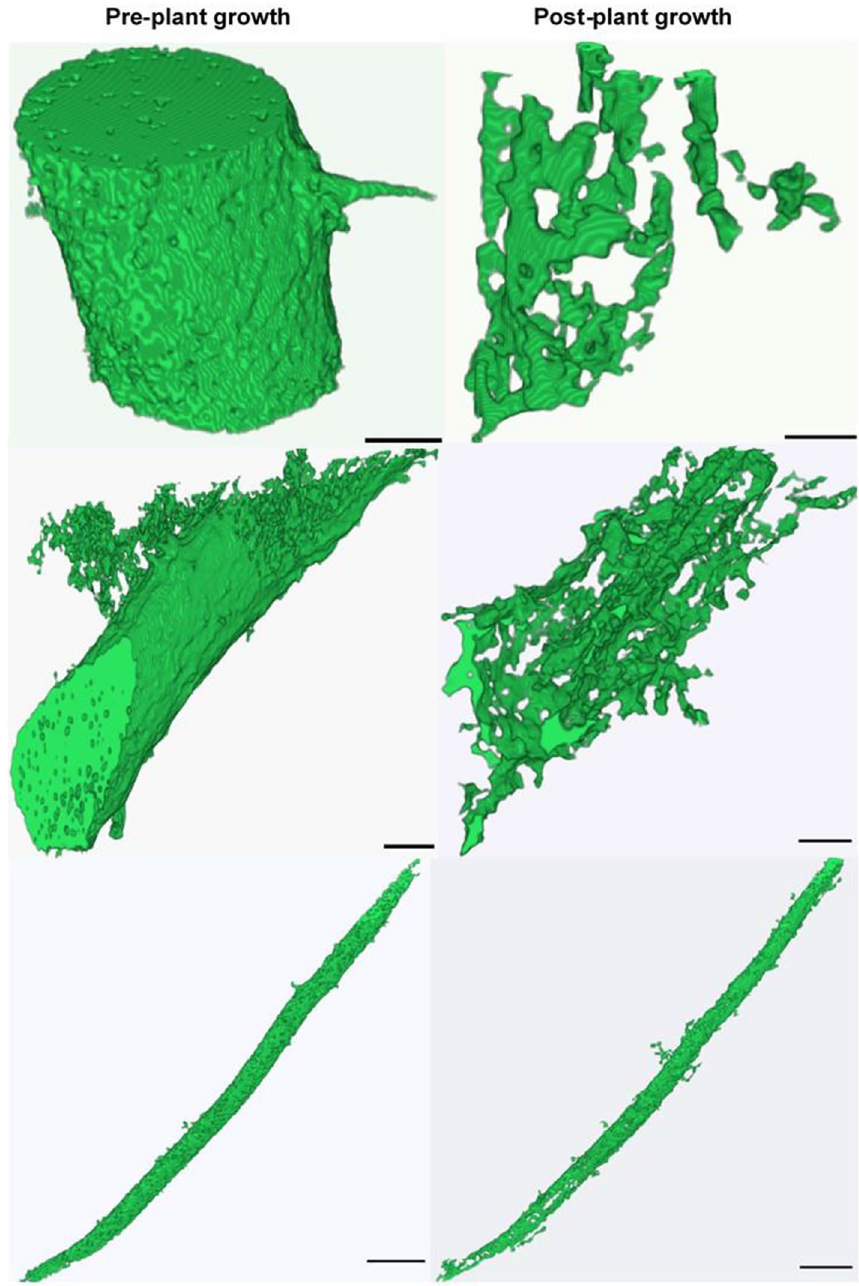
Figure 9. POM decomposition during the incubation period of plant growth experiment. Shown are examples of different types of POM fragments before (left) and after (right) plant growth incubation